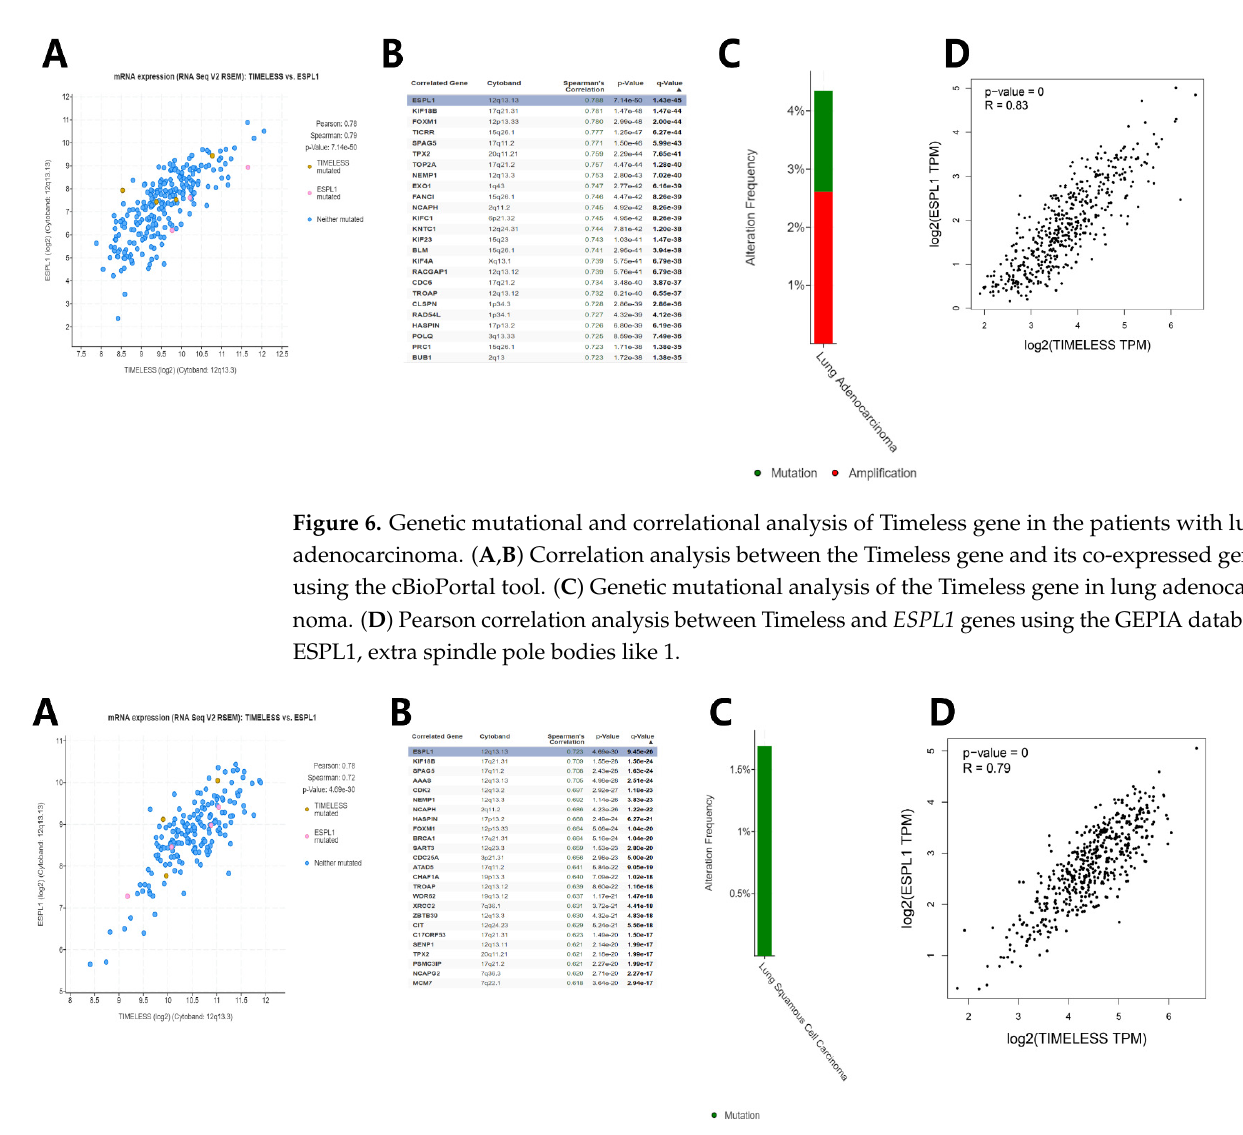
Figure 7. Genetic mutational and correlational analysis of Timeless genes in the patients with lung squamous cell carcinoma. ( A , B ) Correlation analysis between the Timeless gene and its co ‐ ex ‐ pressed genes using the cBioPortal tool. ( C ) Genetic mutational analysis of the Timeless gene in lung squamous cell carcinoma. ( D ) Pearson correlation analysis between Timeless and ESPL1 genes us ‐ ing the GEPIA database. ESPL1, extra spindle pole bodies like 1.